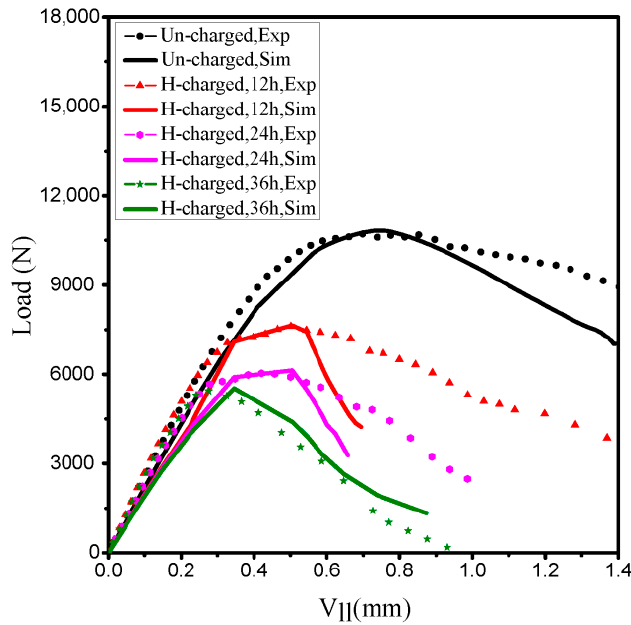
Figure 10. F − V ll curves from experimental data and results of numerical simulations. (Exp: F V − curves from experimental data and results of numerical simulations. (Exp: ex- Figure 10. ll experiment; Sim: simulation). periment; Sim: simulation)